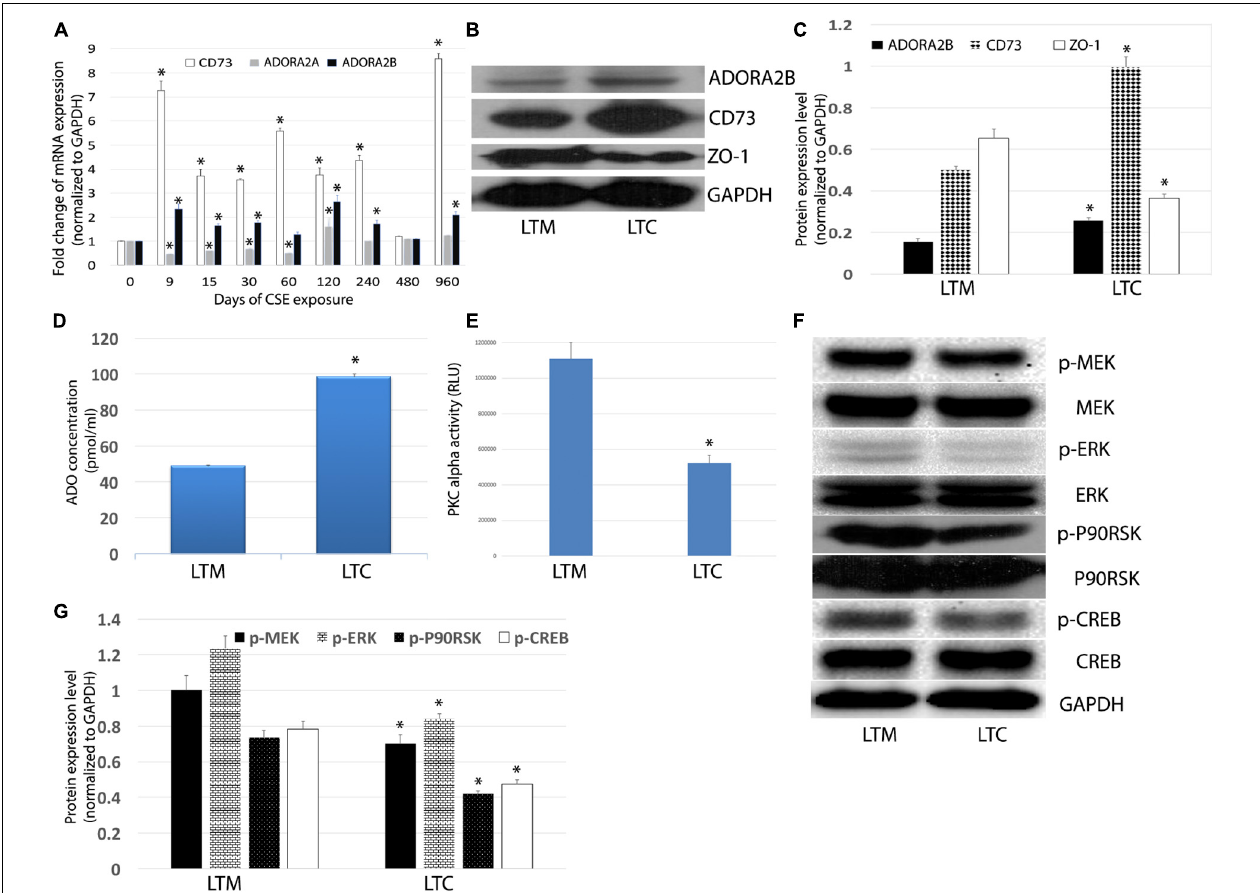
FIGURE 3 | (A) Effects of longterm CSE on transcript levels of ADORA2B. Expression of mRNA in airway epithelial cells treated with CSE for 3 years. Values are mean ± SE, ∗ indicated p < 0.05. (B) CSE stimulates ADORA2B, CD73, and ZO-1 protein expression. (C) Normalized densitometry analysis of ADORA2B, CD73, and ZO-1. ∗ indicated p < 0.05. (D) Extracellular ADO regulated by long-term CSE exposure. The extracellular ADO concentration was measured using HPLC. Data are mean ± SE, ∗ indicated p < 0.05. (E) Activation of PKC alpha inhibited by long-term CSE exposure. Data are mean ± SE, ∗ indicated p < 0.05. (F) Long-term CSE exposure inhibits phosphorylation of MEK, ERK, p90RSK, and CREB. (G) Normalized densitometry analysis of p-MEK, p-ERK, p-p90RSK, and p-CREB. Data are mean ± SE, ∗ indicated p <